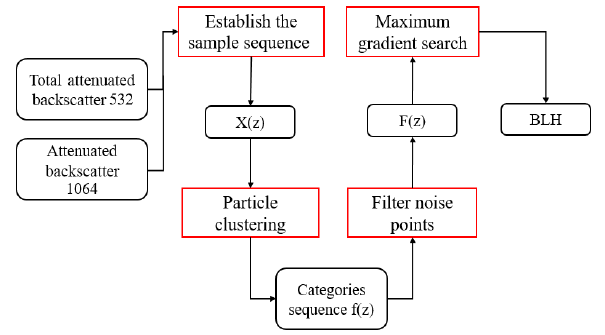
Figure 4. Flow chart of the GDM algorithm. The red boxes indicate the four calculation